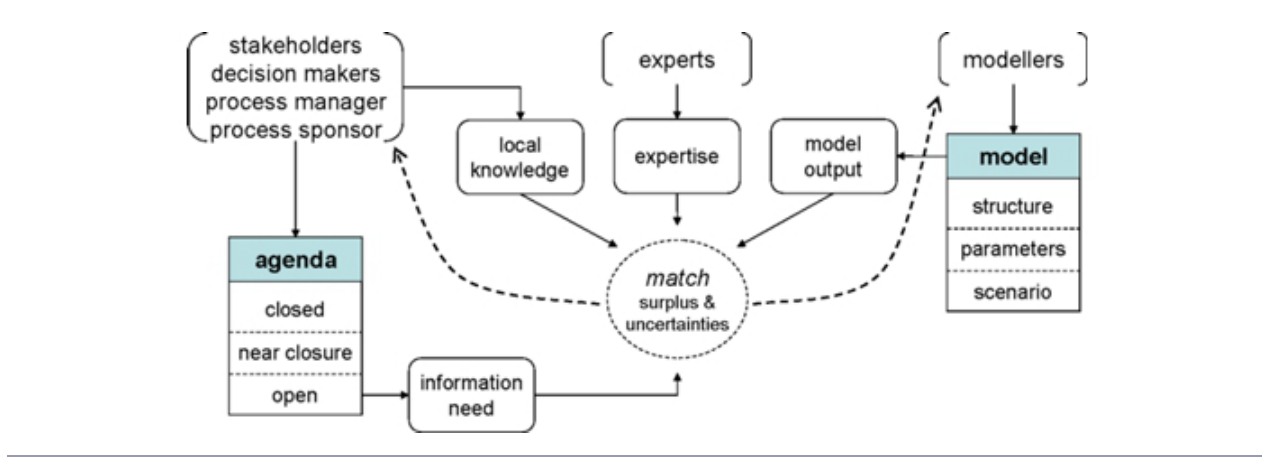
Fig. 1. Elements of a model-informed participatory policy